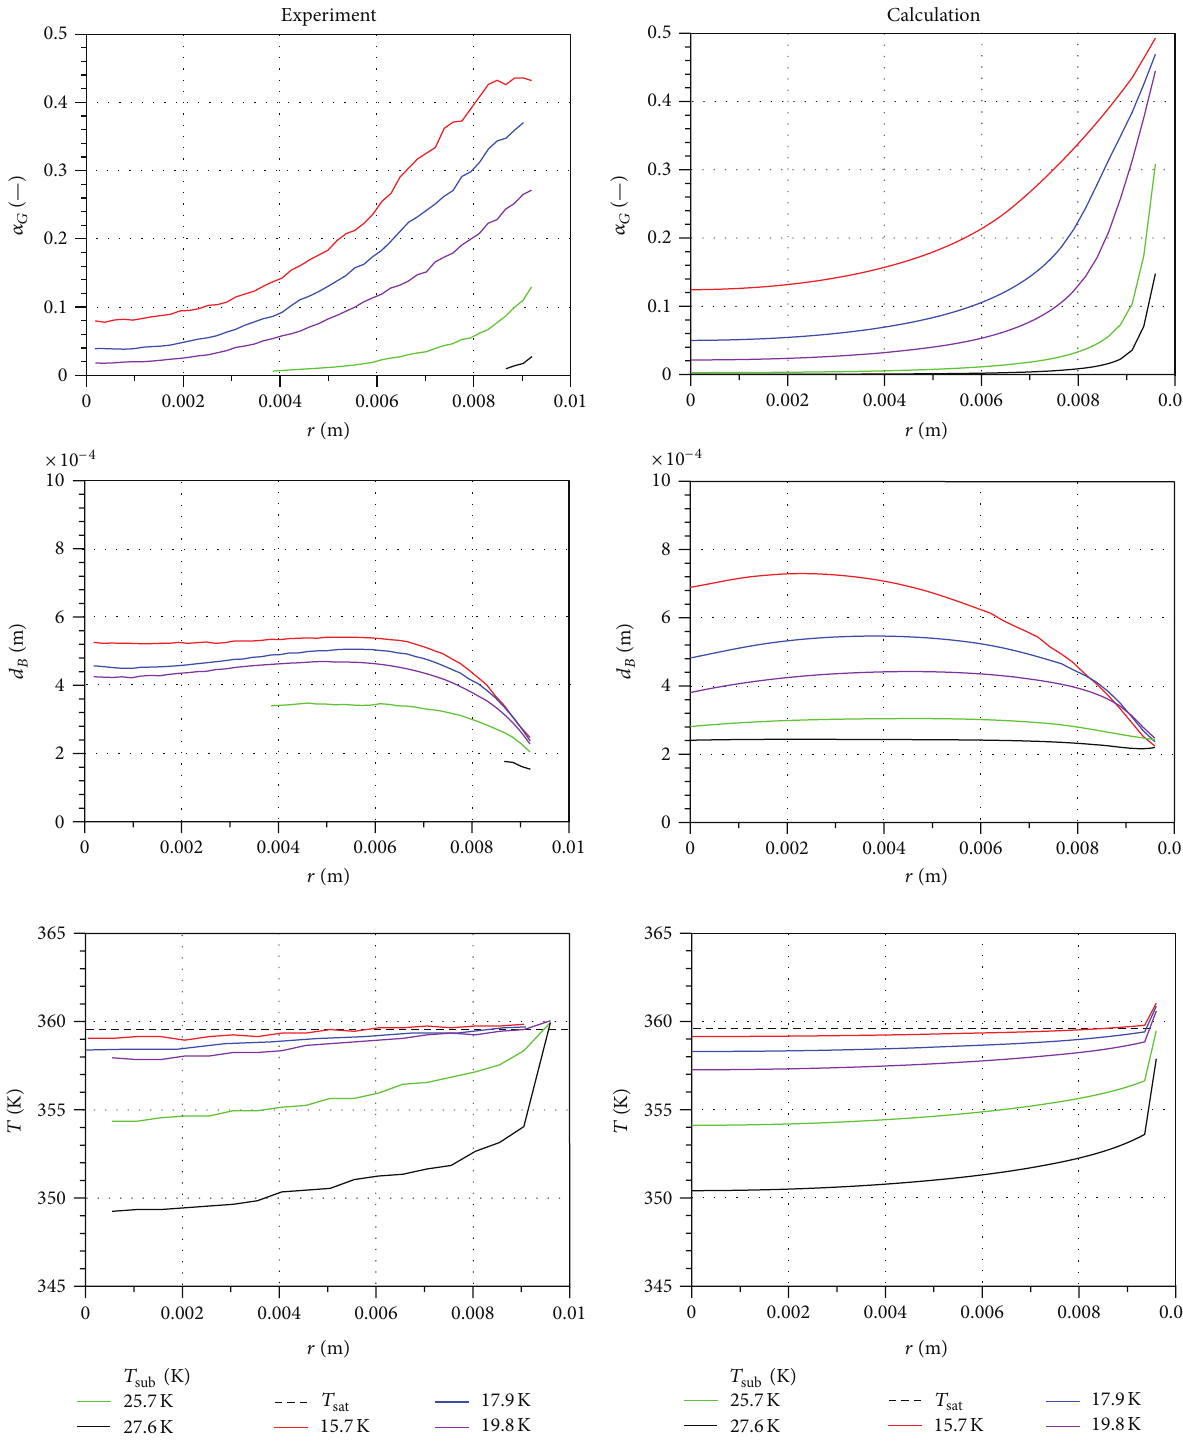
F 9: �as volume fraction, bubble si�e, and li�uid temperature pro�les for test series